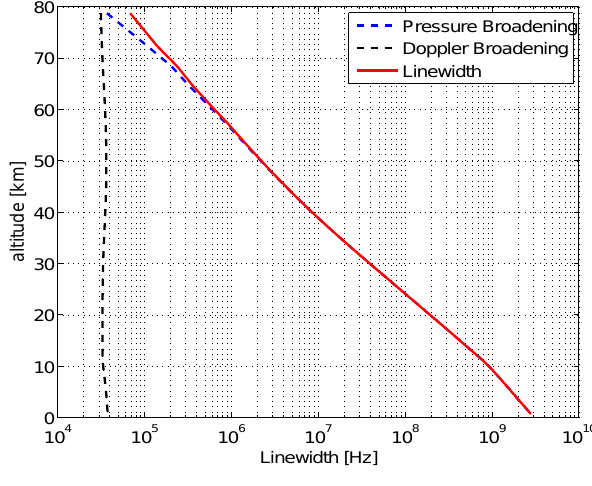
Fig. 3. Altitude dependence of the linewidth of the